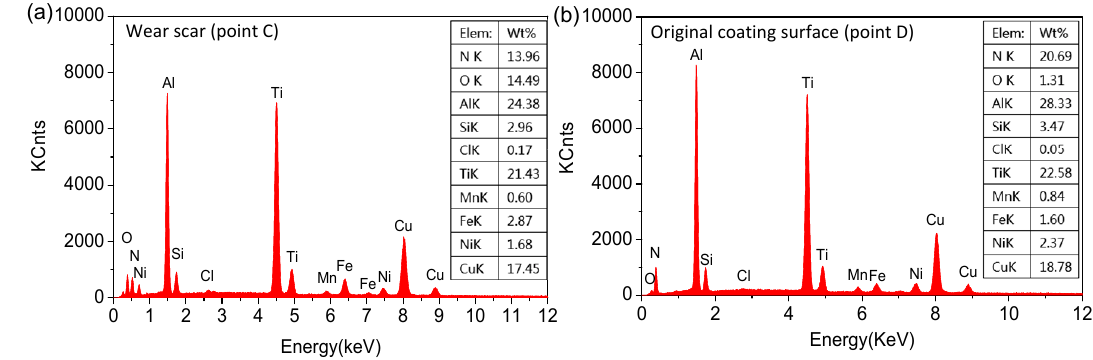
Figure 19. EDX patterns of the TiCN coating on the wear scar and original surface in artificial seawater. ( a ) Wear scar; ( b ) Original coating surface